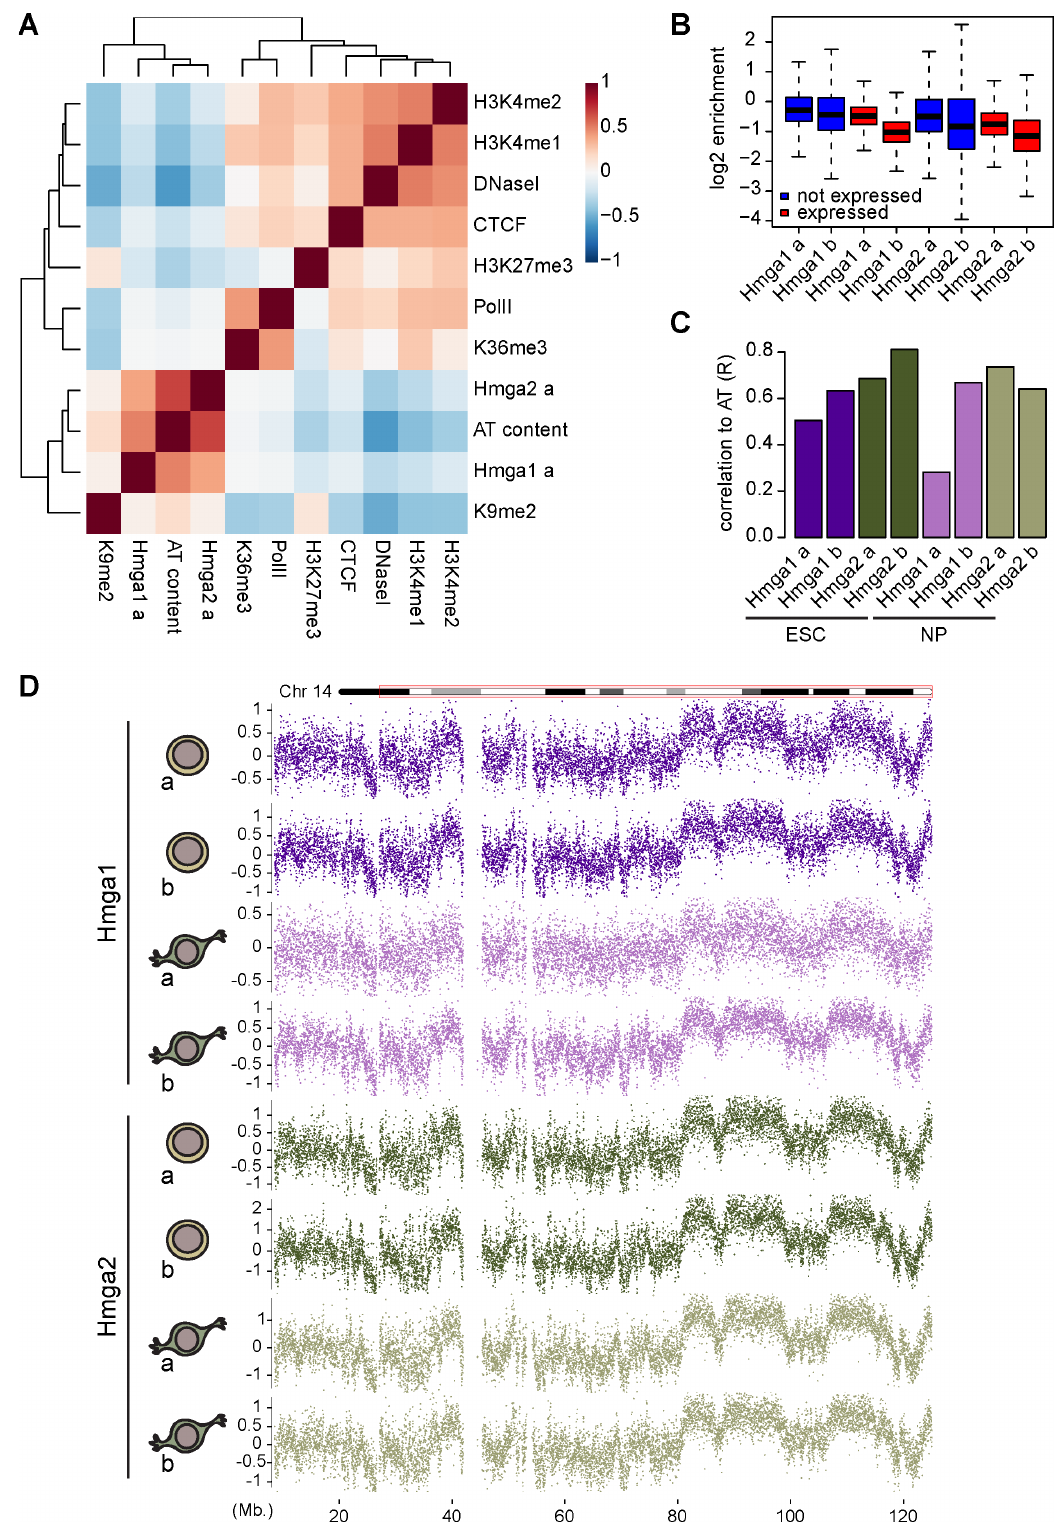
Fig 3. Invariance of Hmga1-2binding in different chromatin environments and in neuronal progenitor cells. (A) Correlation heatmapof a representative Hmga1-2replicateversus chromatinmarks and AT content. Hmga1 and Hmga2